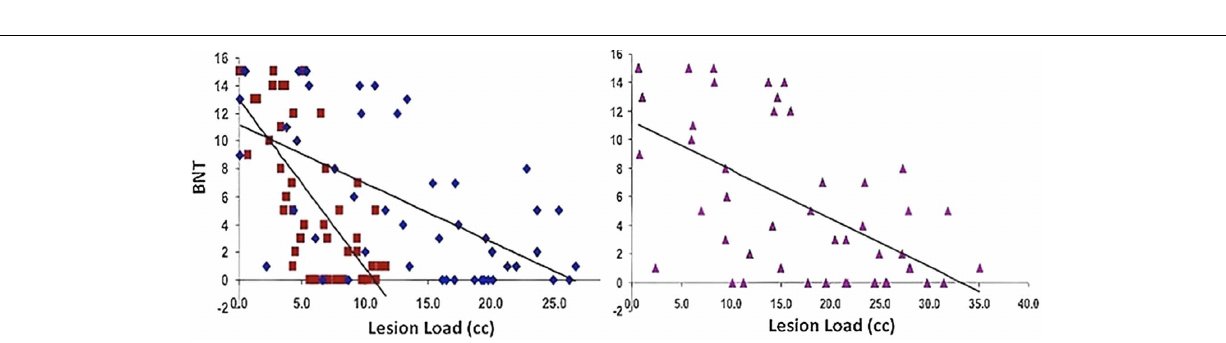
( Table 3 ). For naming, automatic grouping in a two-step